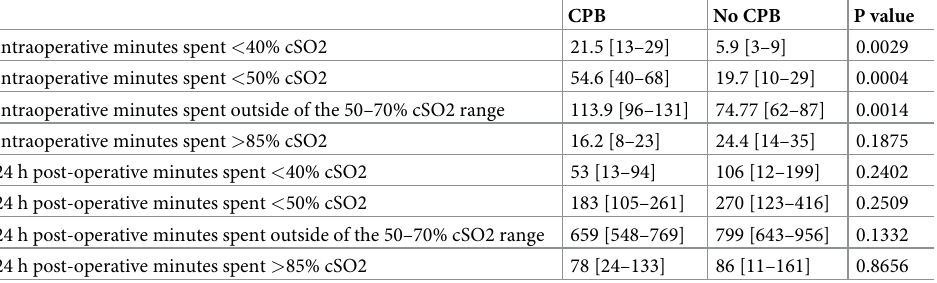
Table 3. Differences in cSO2 values between CPB and no CPB